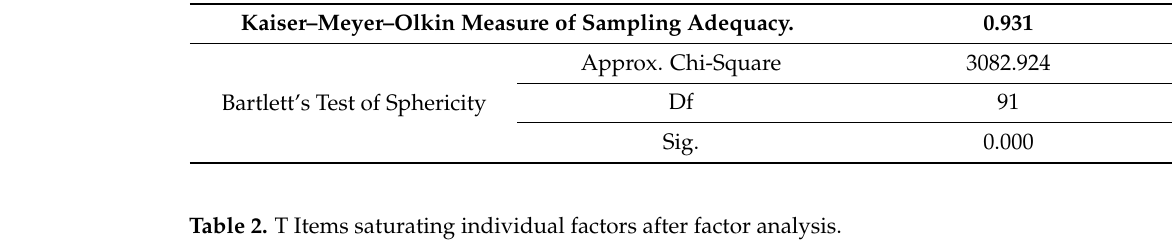
Table 1. KMO and Bartlett’s Test.